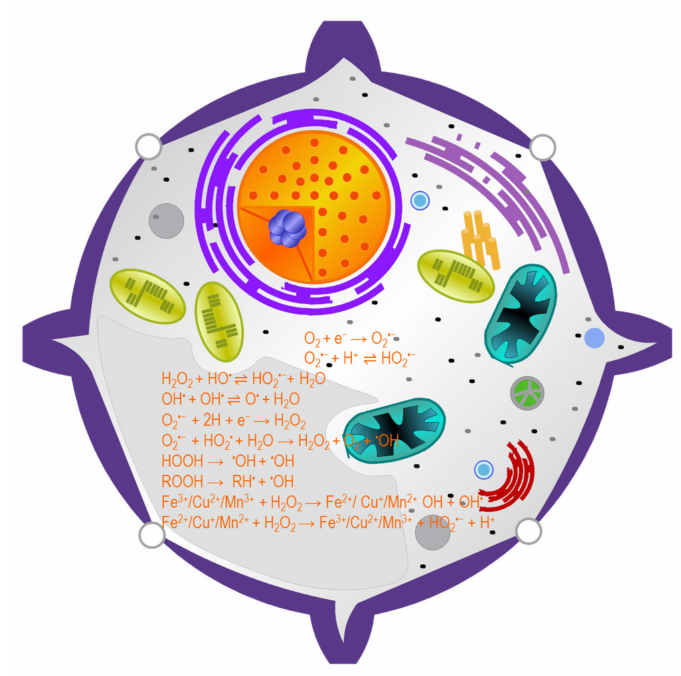
Figure 2. Reactions associated with reactive oxygen species production in